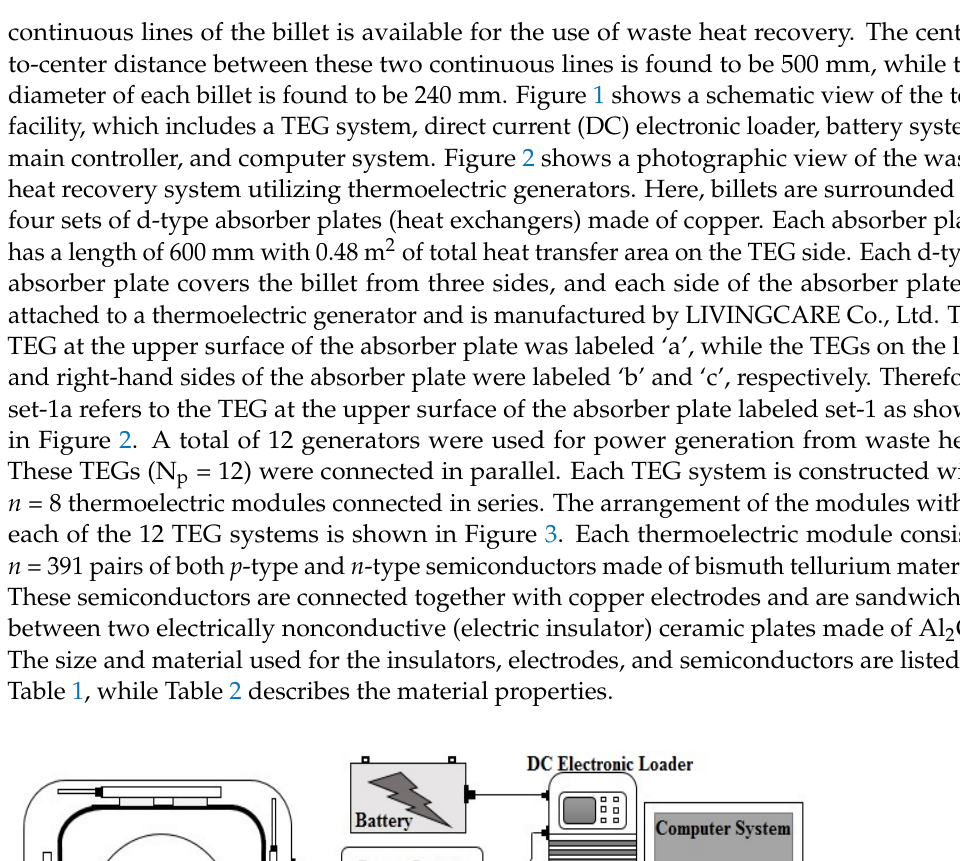
erators (TEGs). Figure 3. Arrangements of thermoelectric generators. Table 1. Specification of semiconductor. Module Specification